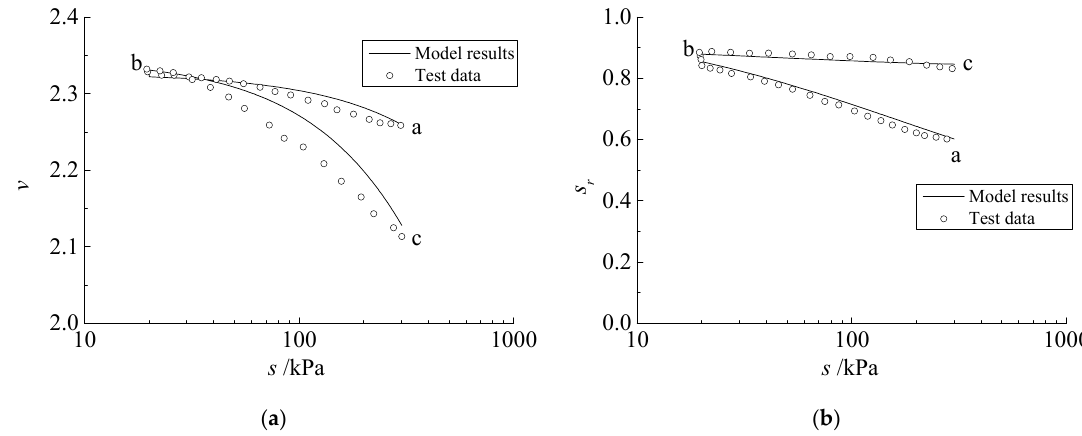
Figure 5. Comparison between modeling results and Test 8 measured data for bentonite/kaolin mixture material during the wetting–drying cycle: ( a ) specific volume; ( b ) degree of saturation.